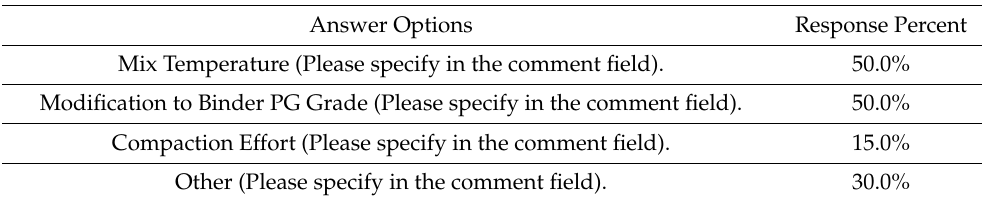
Table 15. Technical considerations for asphalt mixes containing